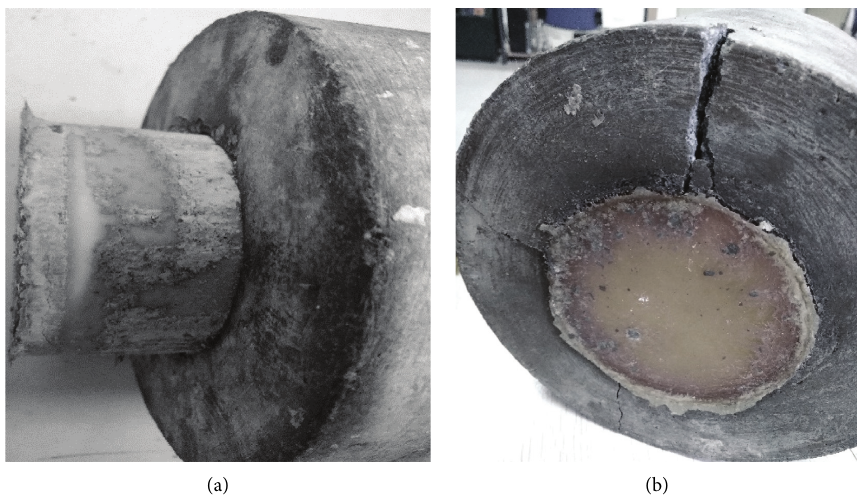
Figure 5: (a) A typical form of destruction. (b) Concrete fragmentation.